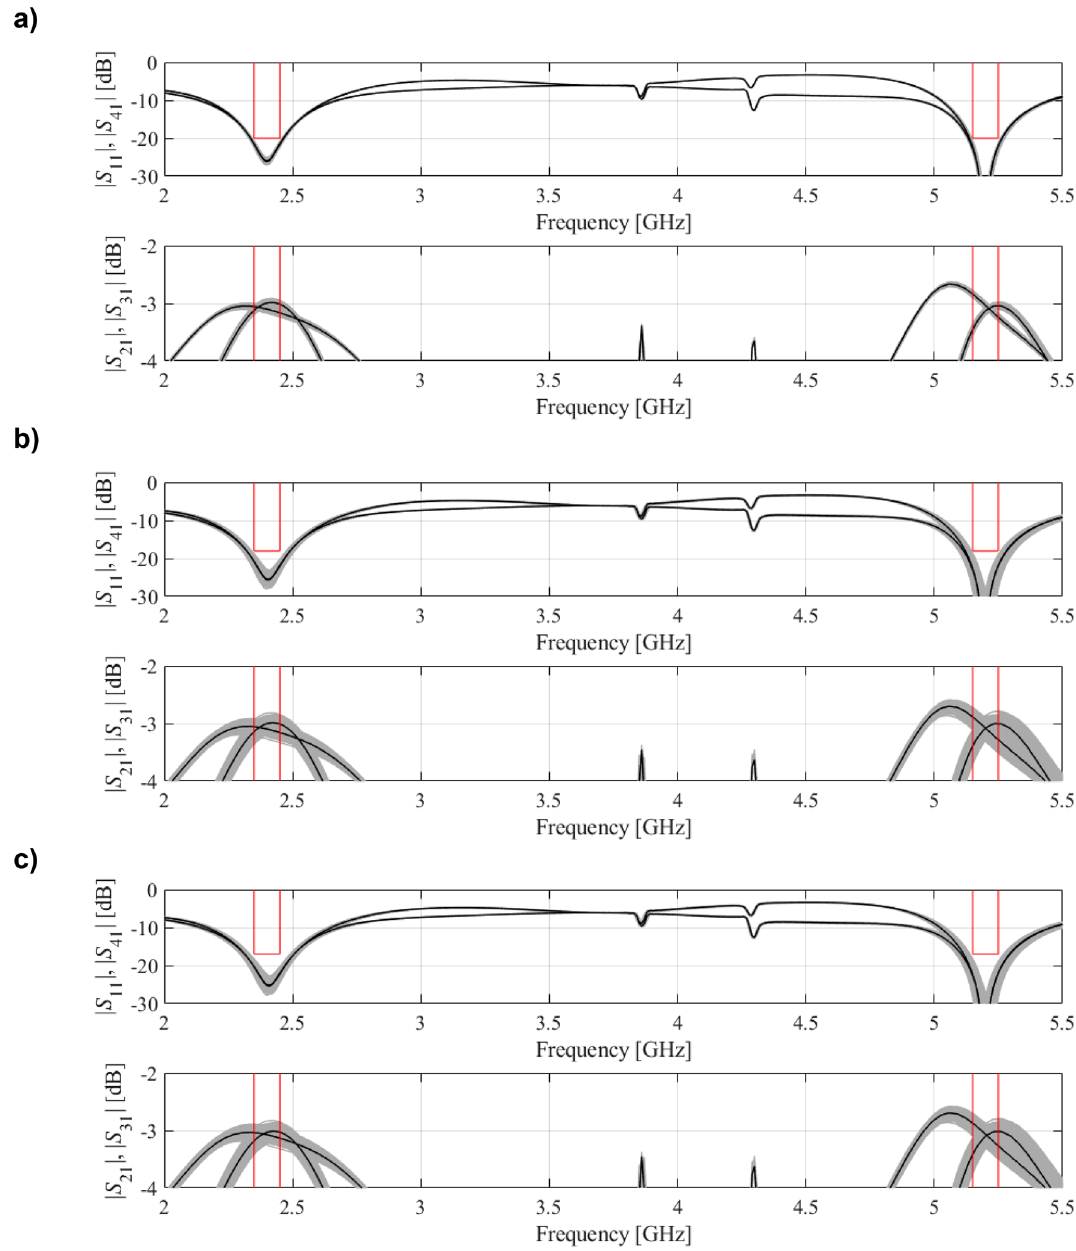
Figure 13. EM-based Monte Carlo analysis of the dual-band BLC of Fig. 11 at some trade-off points of Table 3. The circuit output at the selected trade-off design is marked black, whereas 500 random trial points rendered following the probability distribution of the variance σ = F r are shown using gray color. The specs are indicated by thin lines: ( a ) design x (2) , ( b ) design x (4) , ( c ) design x (5)